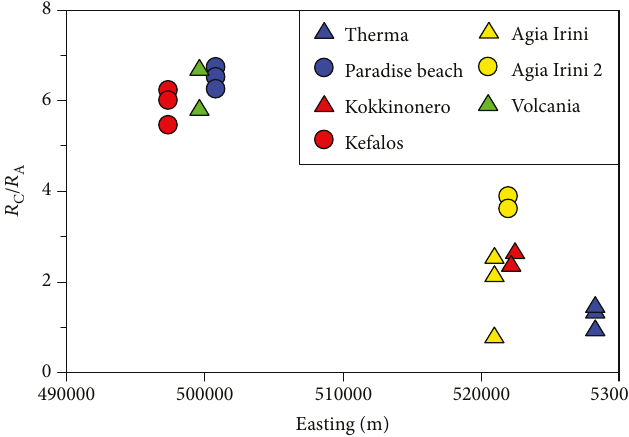
Figure 5: Geographical distribution of the R CO / 3 He vs. δ 13 C-CO binary diagrams (Figure 4). In the 2 2